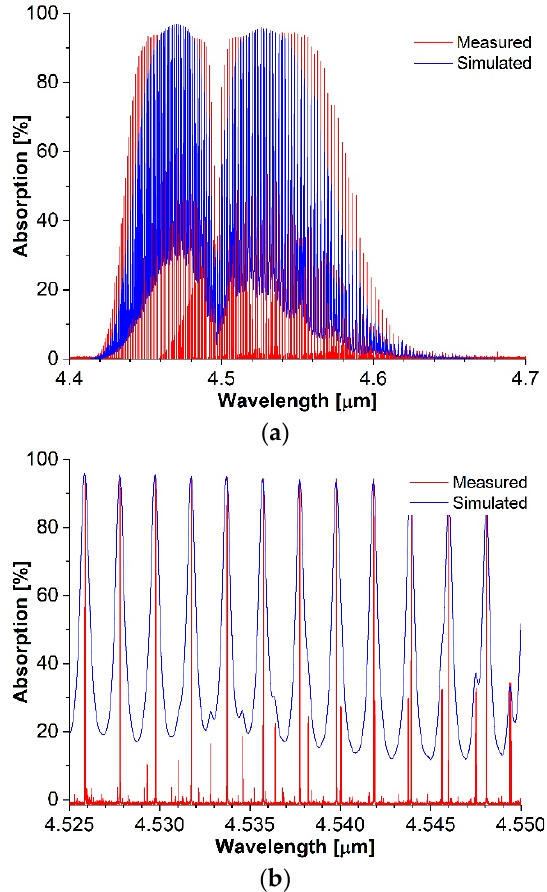
Figure 1. Mid ‐ infrared absorption spectra of nitrous oxide from the HTRAN 2008 database and measured with an IFS 125HR spectrophotometer ( a ), and enlarged part of the spectra to show the differences ( b ). The theoretical spectra were obtained for the following settings: resolution 0.025 cm − 1 (as a result of the maximum datapoints in the range of 4–5 μ m), temperature 296 K, and partial pressure 3.2 × 10 − 7 atm. The measurement was carried out in the following conditions: resolution 0.0035 cm − 1 ; 10 cm gas cell, including CaF 2 windows; 10 mbar; temp. 23 °C; beam splitter CaF 2 ; and liquid ‐ nitrogen cooled InSb detector.